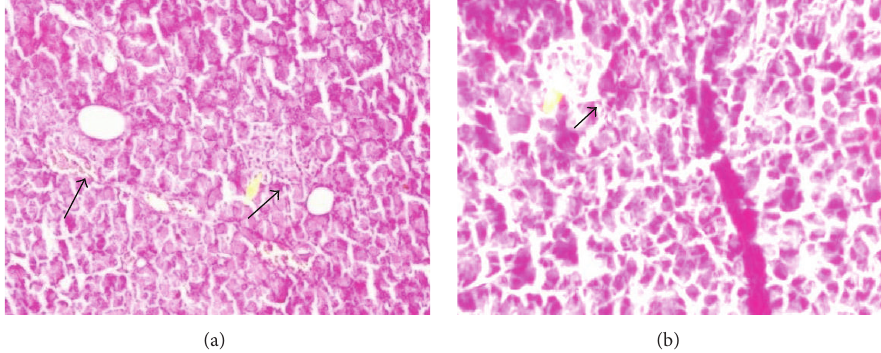
Figure 7: Histopathological changes of the Pancreas. (a) The NC group of rats pancreas were characterized by an organized pattern and showed normal architecture of beta cell mass. (b) The HF-DC group of rat pancreas damaged islets of Langerhans and the atrophy of beta cells showed reduced beta cell mass. The arrow showed beta cell mass.